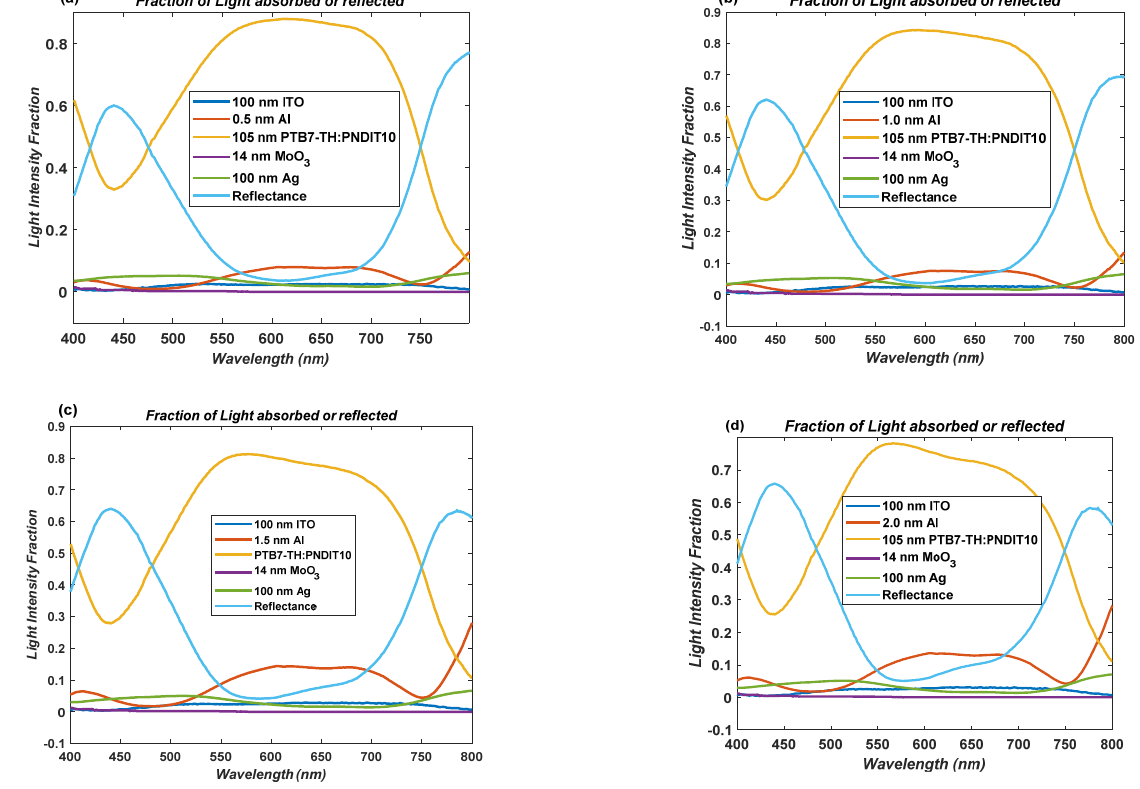
Figure 6. Absorption and reflection plotted as a function of the wavelength of the incident solar radiation in the inverted OSC with the structure: ITO(100 nm), Al (x nm) active layer blend (105 nm), and MoO 3 (20 nm), where ( a ) x = 0.5 nm, ( b ) x = 1.0, ( c ) x = 1.5, and ( d ) x = 2.0.